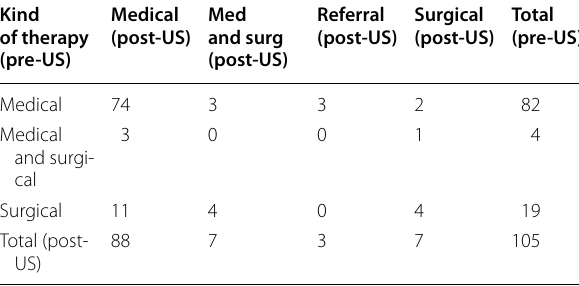
Table 6 Variation of the class of therapy (medical, surgi- cal, or both) after the ultrasound results and variation of